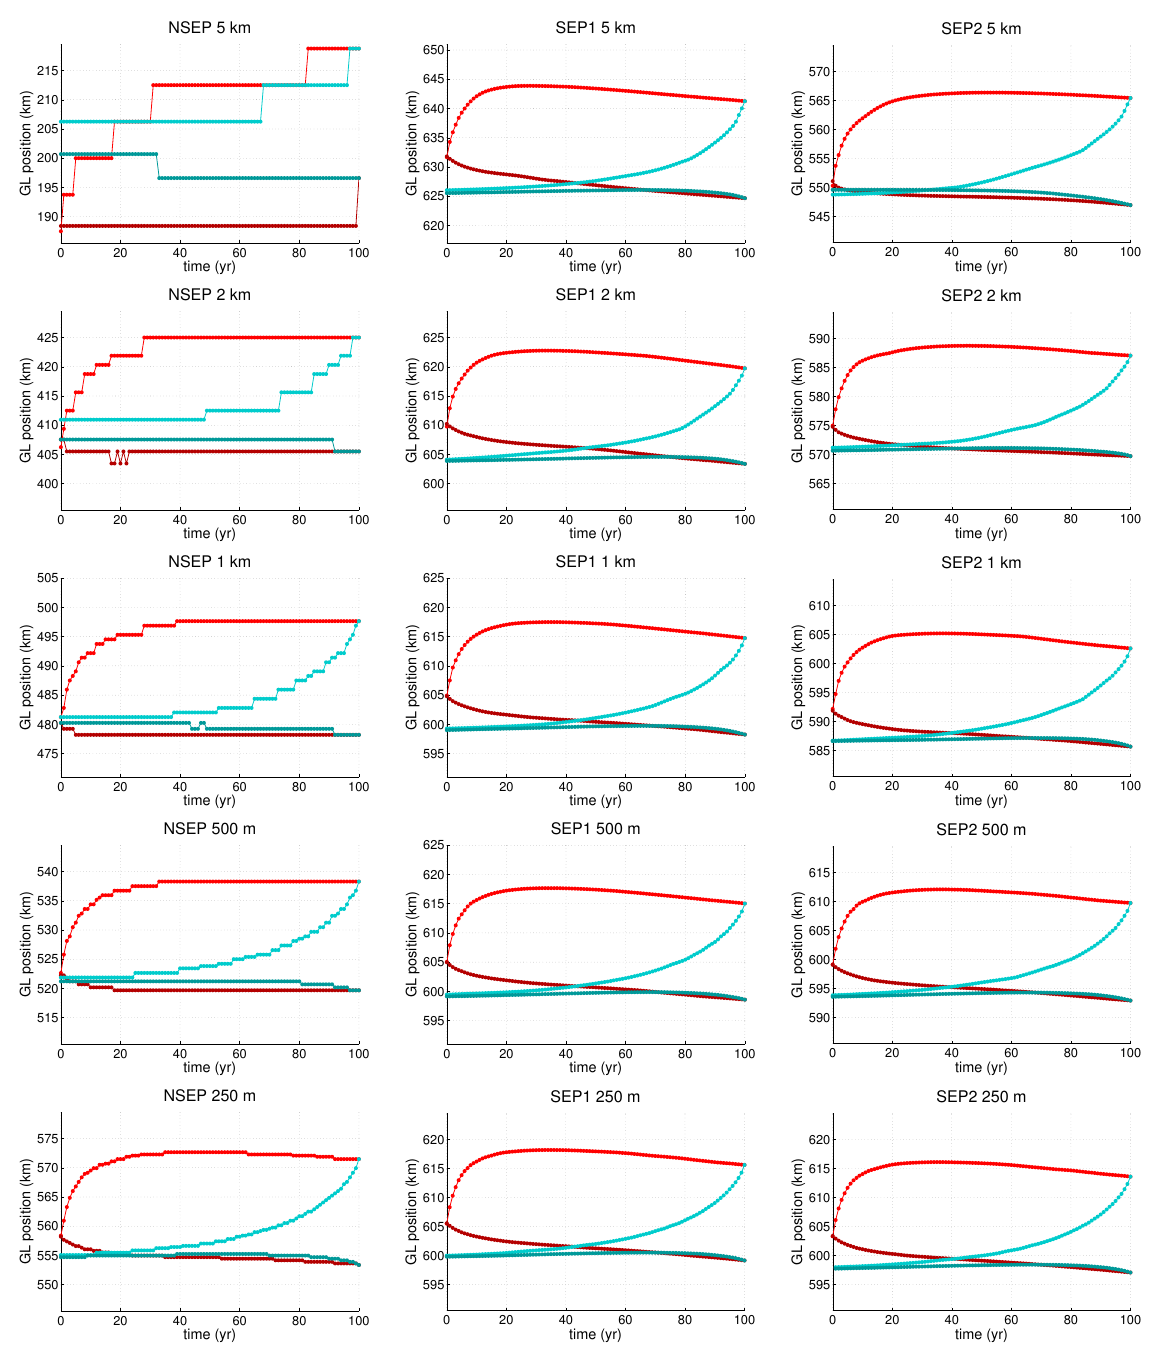
Figure 4. Time-dependent position of the grounding line along the symmetry axis ( y = 0) and the free slip border ( y = 50) during (respectively light red and dark red) and after (respectively light teal and dark teal) the friction perturbation for coarse mesh resolutions. y axes have the same scale for all simulations. x axes (time) is reversed after the perturbation experiment (teal lines).